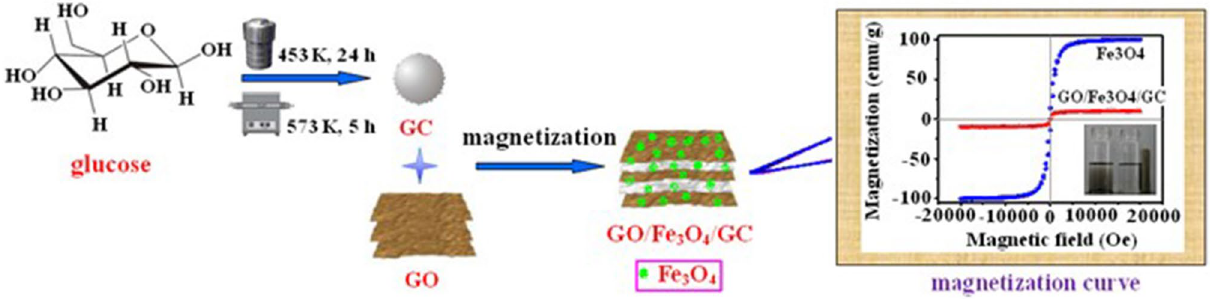
Figure 1. The fabrication process and magnetization curve of GO/Fe 3 O 4